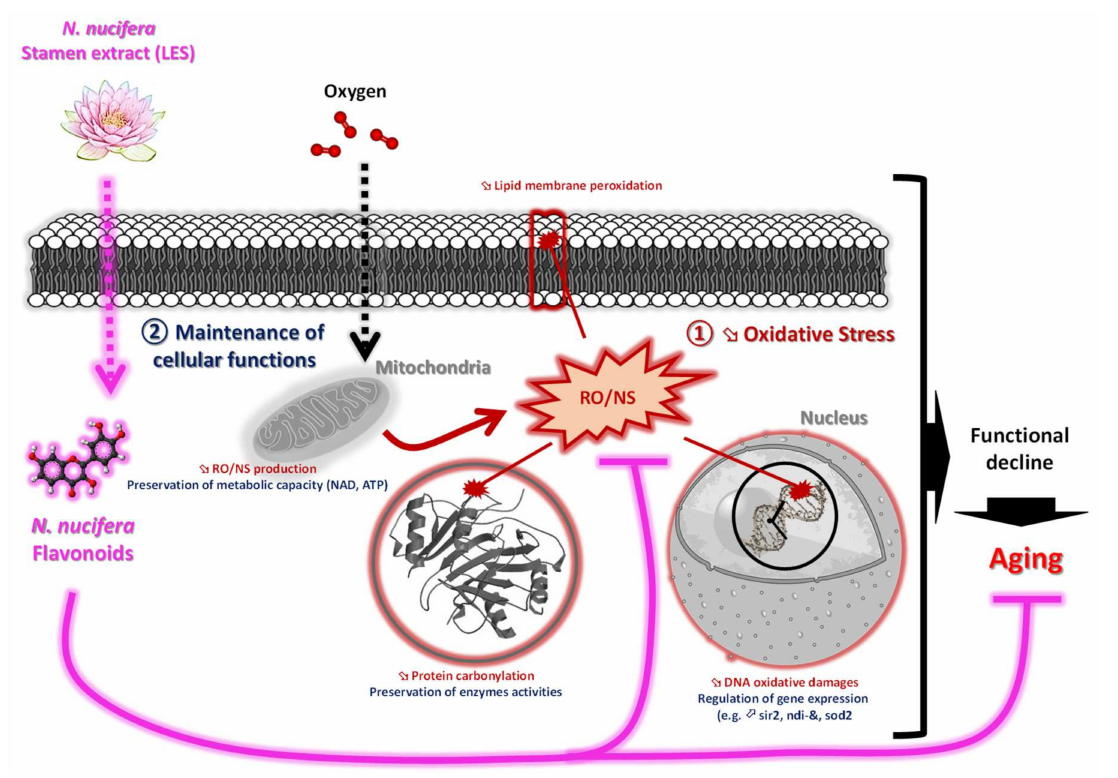
Figure 7. Simplified view summarizing the effects of LSE on chronological aging in yeast. Supplementary Materials: The following supporting information can be downloaded at: https: ratio. LSE: sacred lotus stamen extract (0.5 mg/mL); RES: E -Resveratrol (10 µ M) used as positive